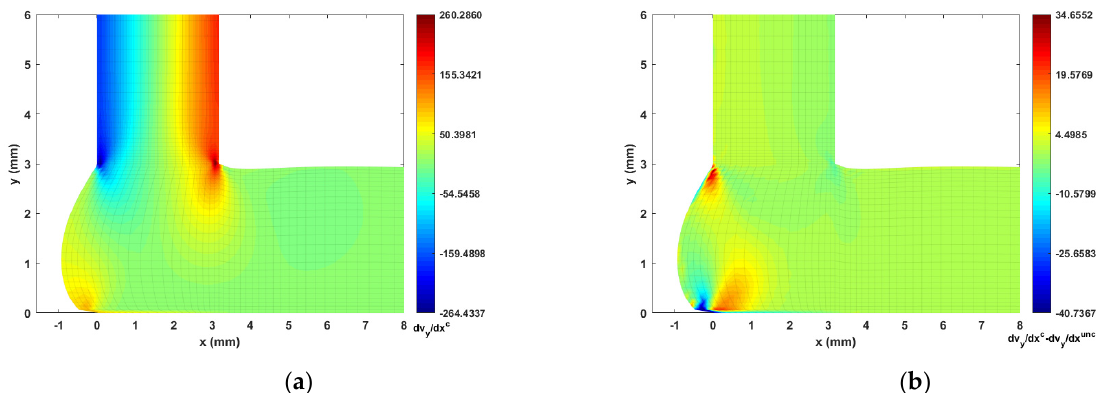
Figure 15. Velocity gradient contour (cid:1856)(cid:1874) (cid:3051) /(cid:1856)(cid:1877) near extrusion-deposition transition region: ( a ) fully coupled solution; ( b ) difference between the fully coupled and uncoupled solutions.